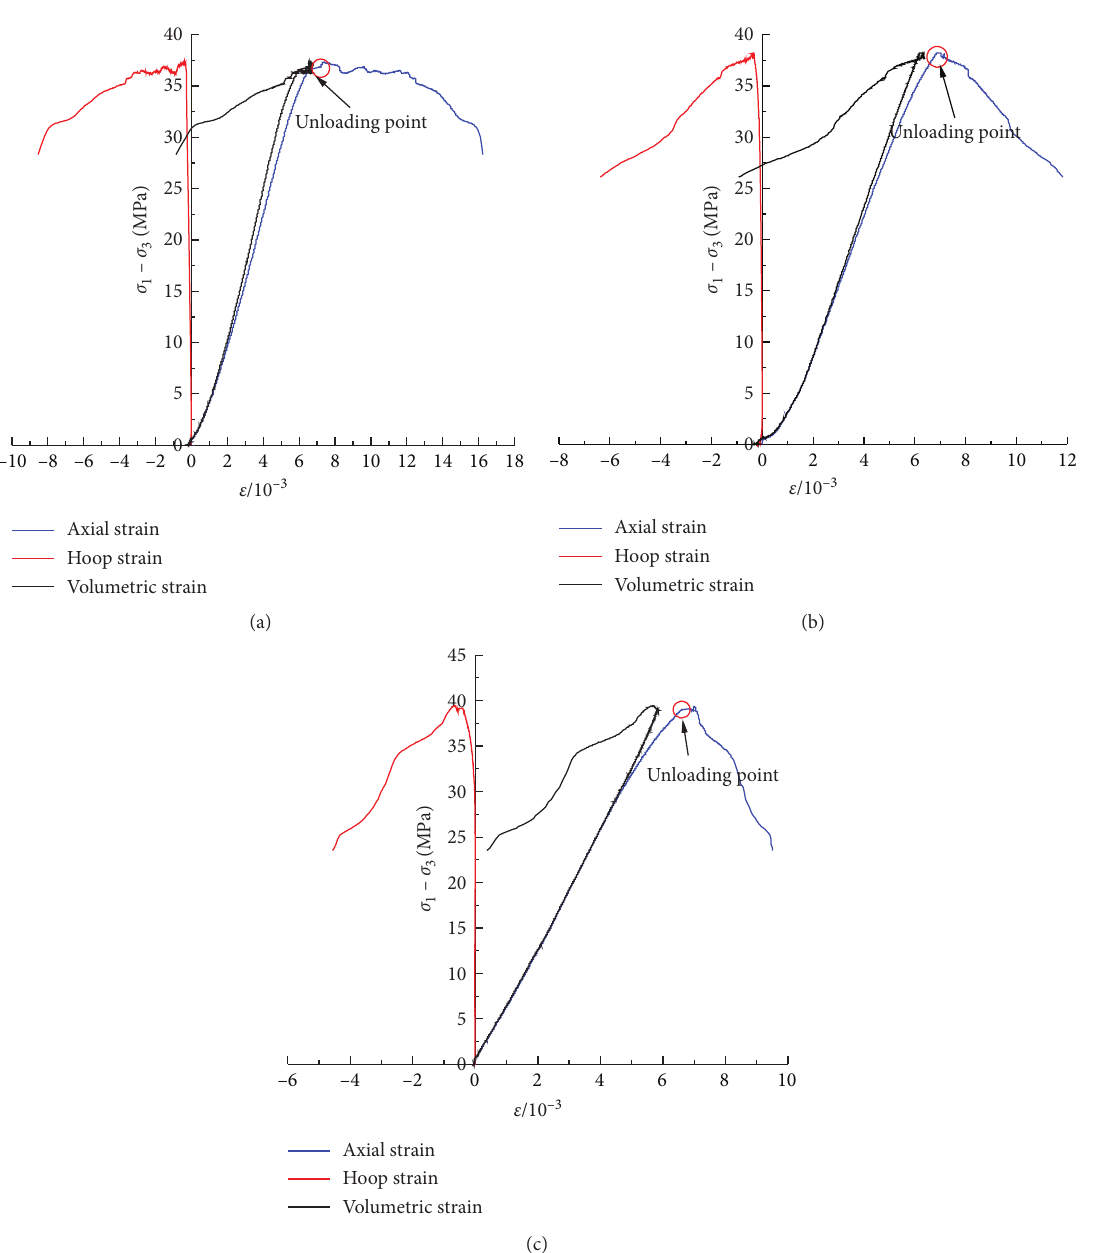
Figure 7: Stress-strain curves at different unloading rates. (a) 0.5MPa/min, (b) 1.0MPa/min, and (c)